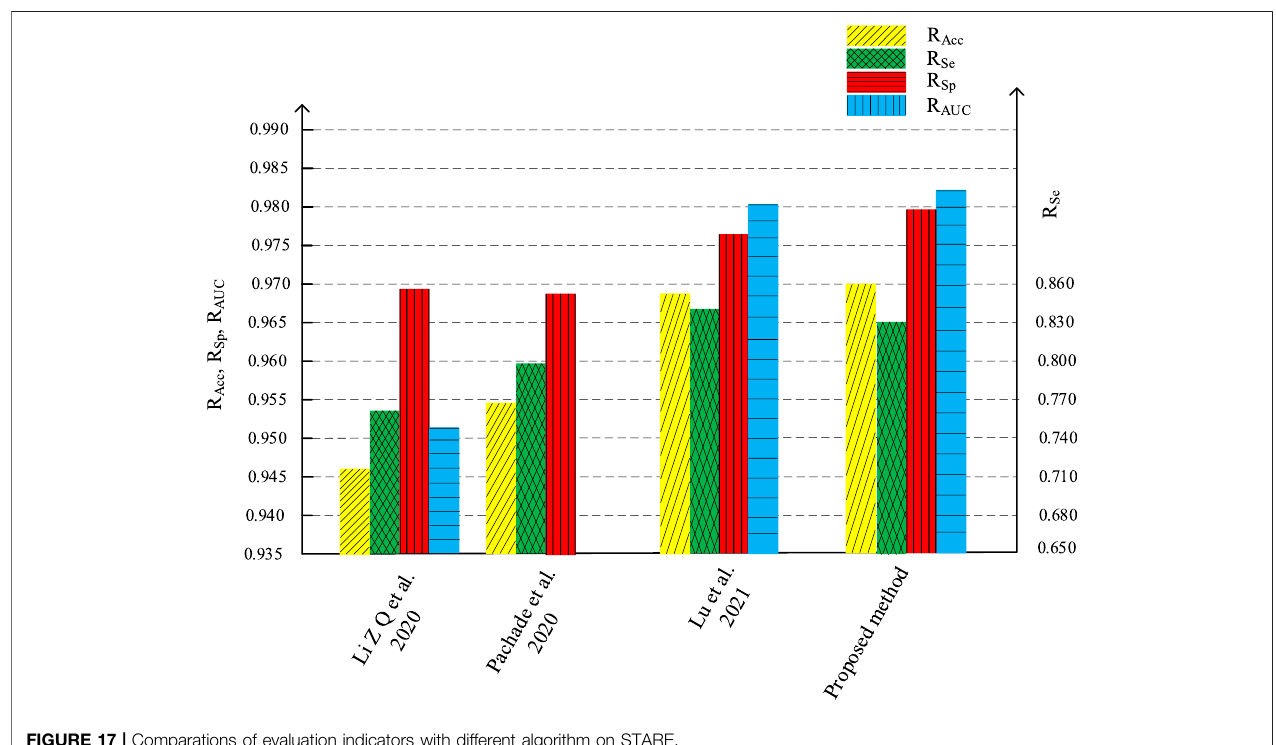
FIGURE 17 | Comparations of evaluation indicators with different algorithm on